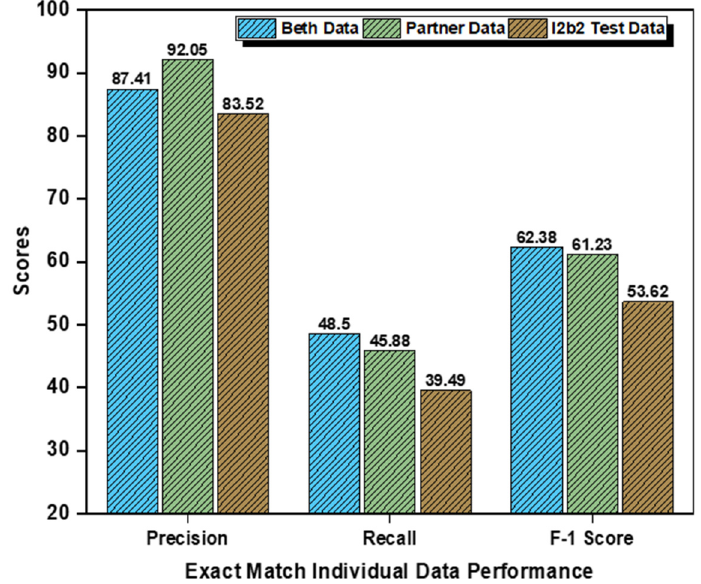
Figure A1. Individual dataset performances, employing exact term matching to UMLS. Table A1. Individual concepts’ performance measures for the Beth, Partner, and Test datasets, employing exact term matching to UMLS.